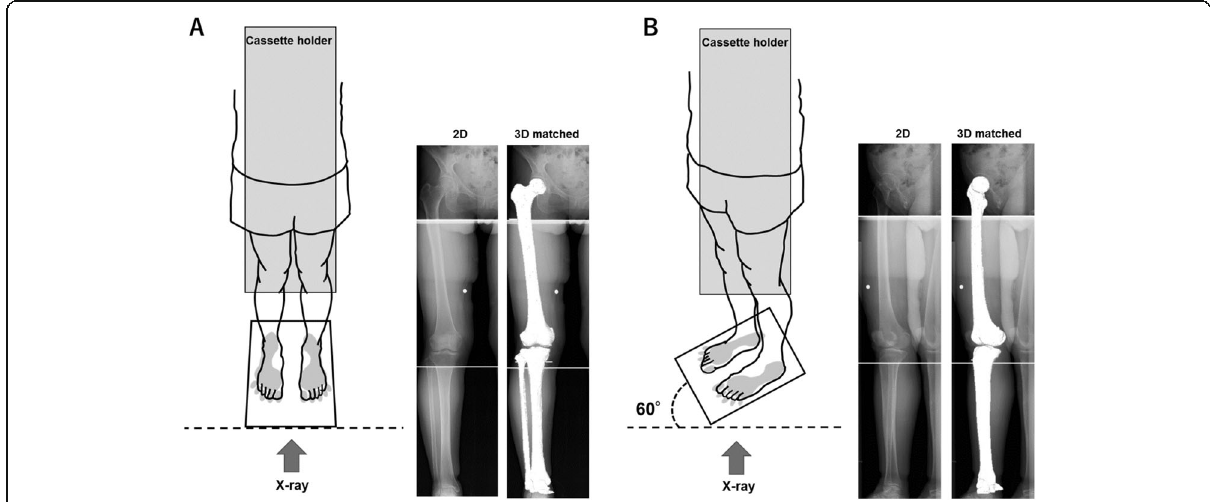
Fig. 2 Schematic illustration of the three-dimensional (3D) to two-dimensional (2D) image registration technique. For the biplanar radiography images, the subjects stood at 0° ( a ) and 60° ( b ) to cassette holder. The 3D digital bone models were projected onto the biplanar radiography images in the weight-bearing conditions, using the three-dimensional (3D) to two-dimensional (2D) image registration